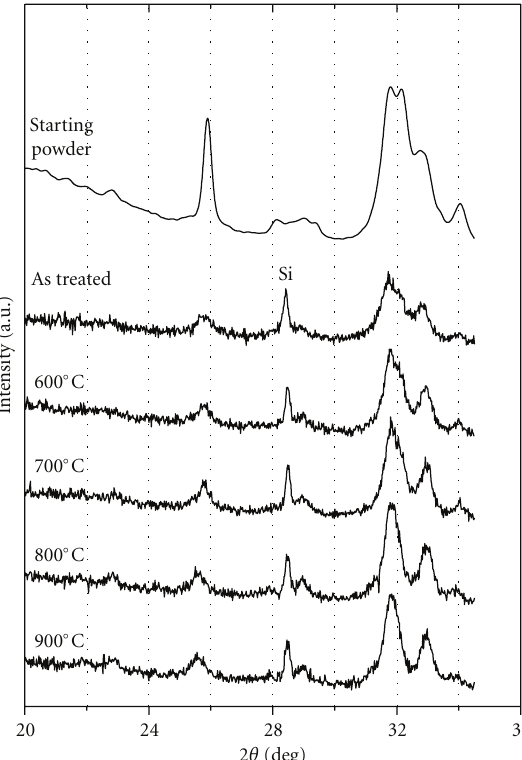
Figure 18: XRD patterns of SiHA deposited on Ti substrate after being heated at various temperatures (all peaks, except of shown Si peak, belong to HA